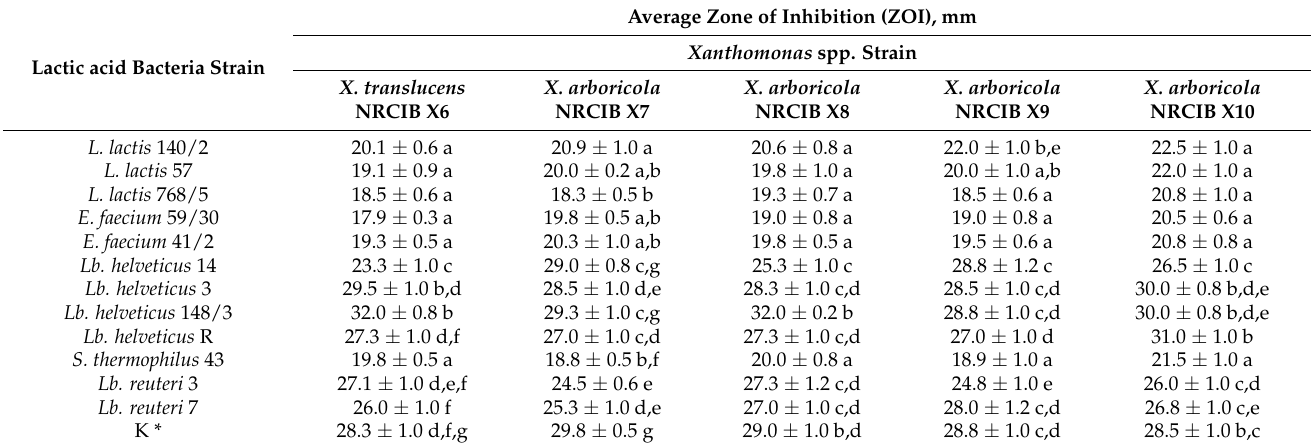
Table 2. Antibacterial activity of different LAB strains against Xanthomonas spp. strains.